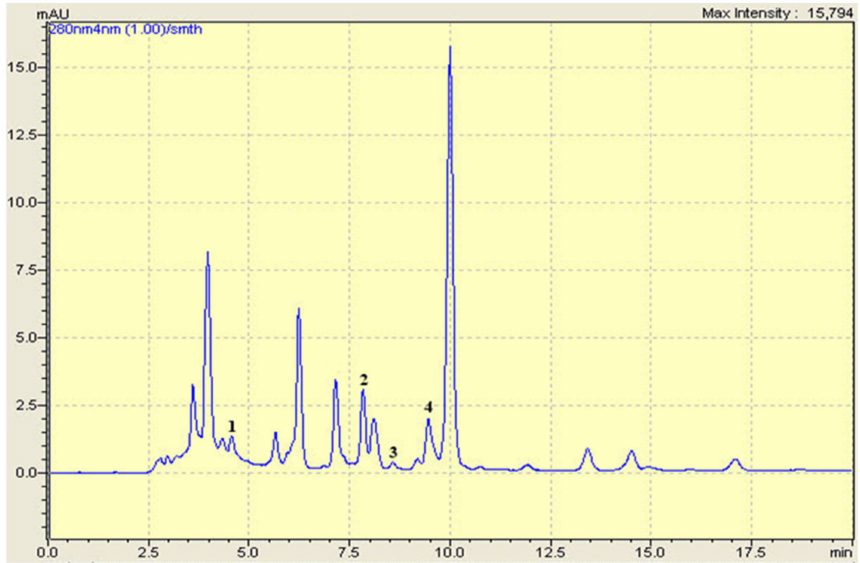
Figure 1. HPLC-DAD chromatogram of M. vulgare hydro-ethanolic extract. (1) Gallic acid, (2) Caffeic acid, (3) Ferulic acid, (4) Quercetin.